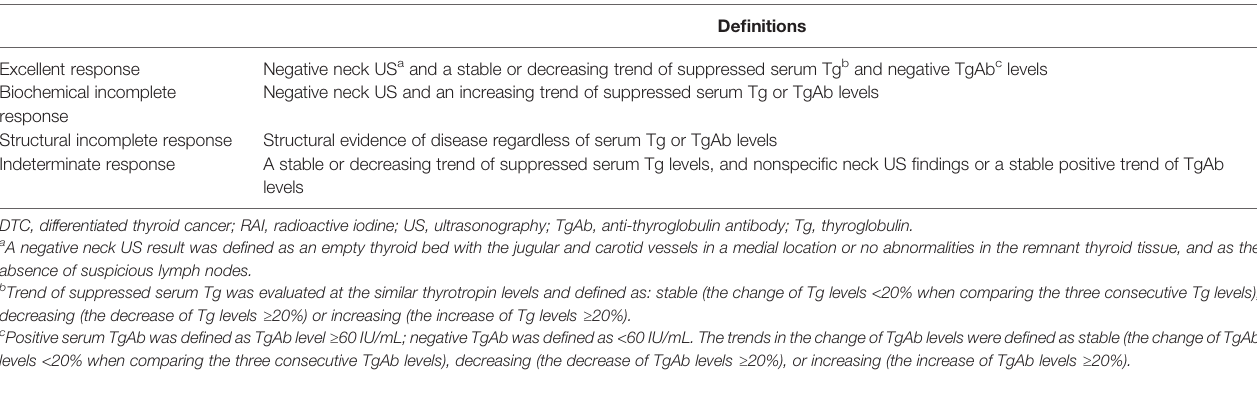
TABLE 1 | The de fi nitions of a new response to therapy assessment in patients with low-risk DTC who underwent total thyroidectomy or lobectomy without RAI.